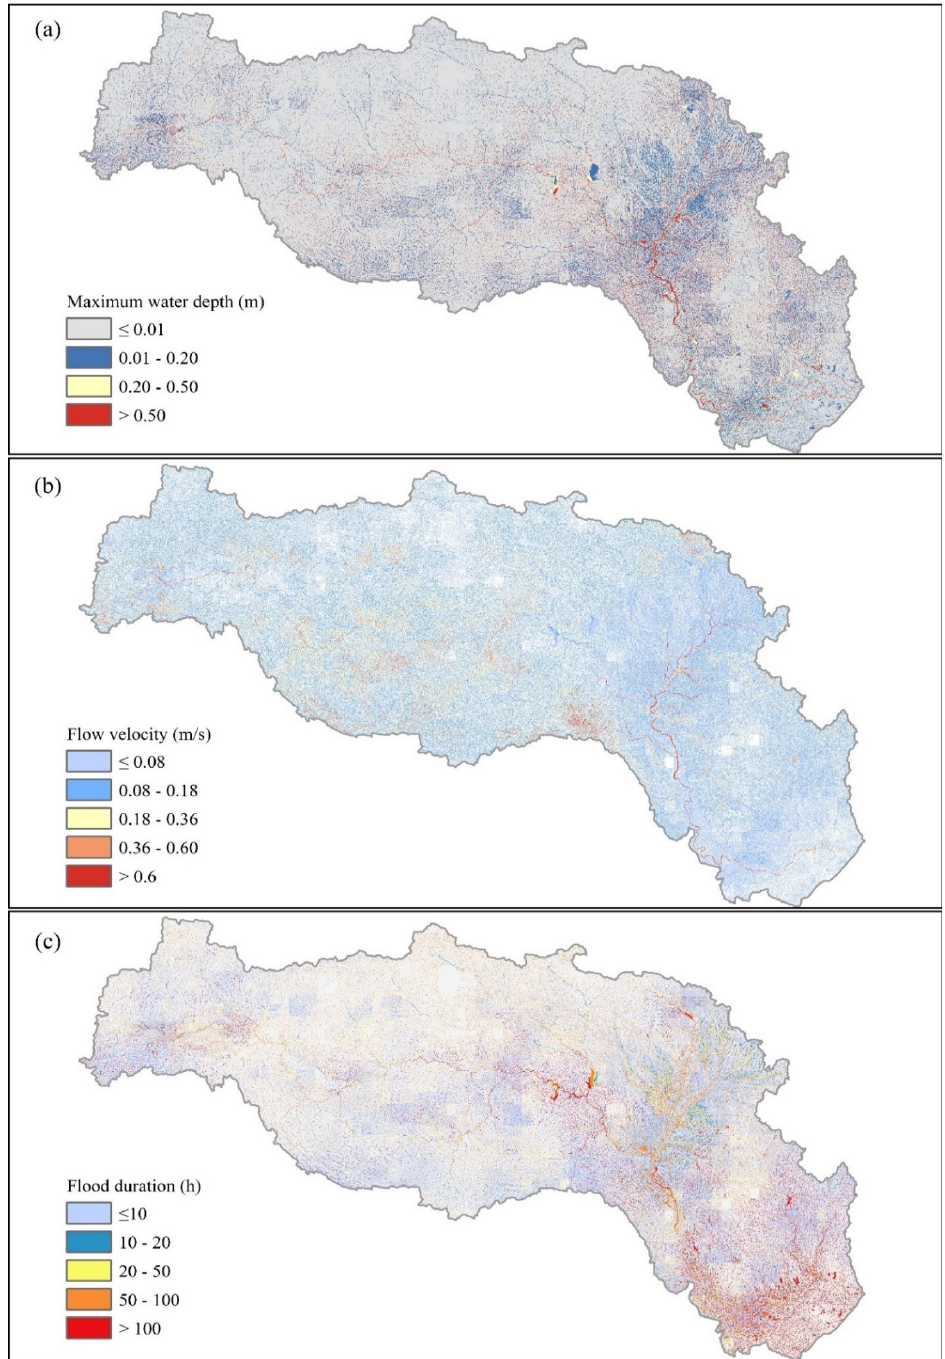
Figure 5. Flood simulation results of ( a ) maximum water depth, ( b ) flow velocity and ( c ) flood duration for the Han River Basin.